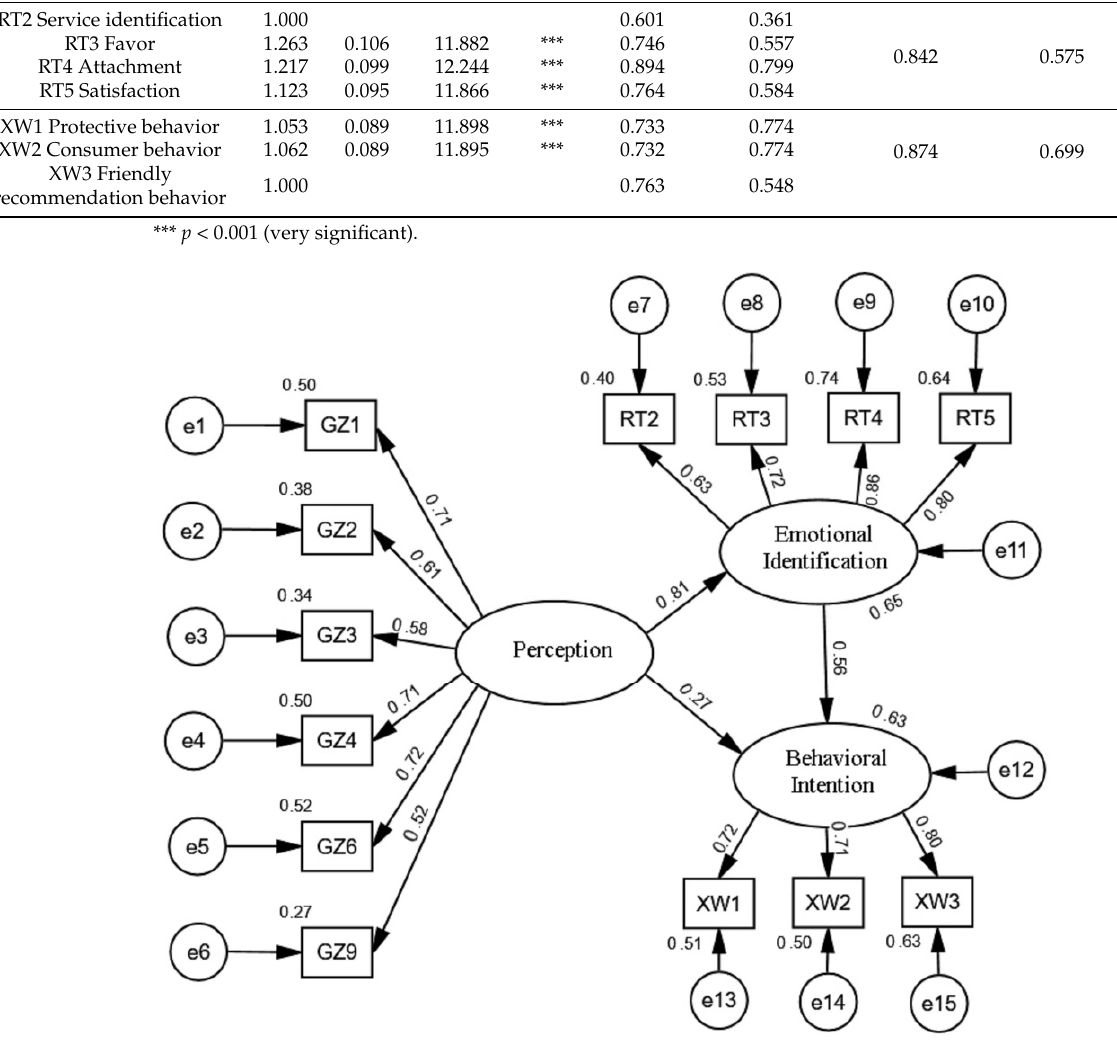
Table 6. Model path and verification.